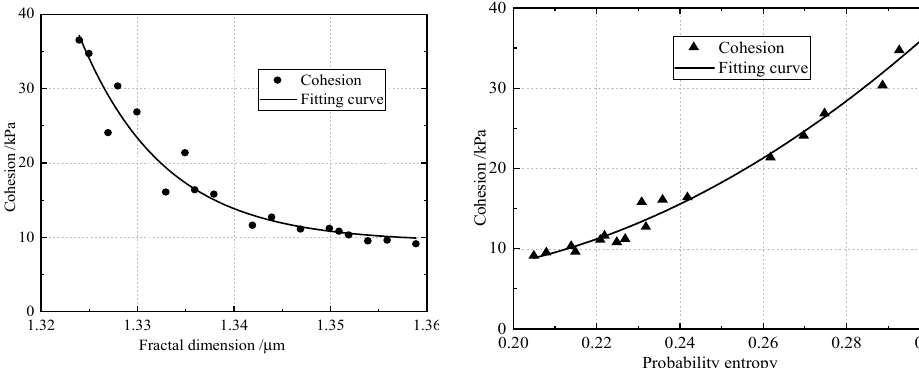
Figure 11. Variation in the C-M-S cohesion with the microscopic parameters.